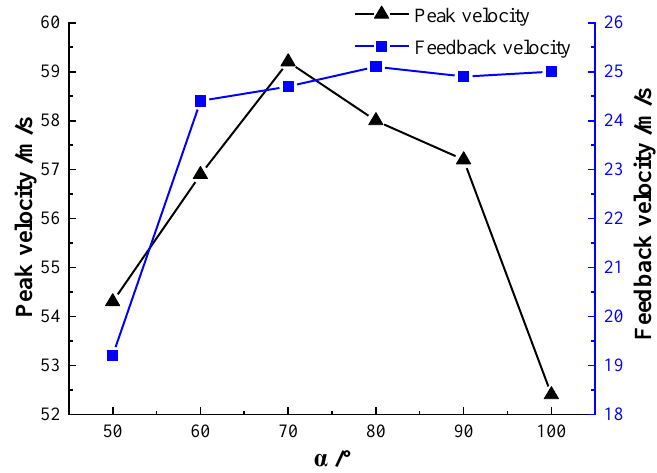
Figure 19. Curves of peak velocity and feedback velocity with wall reflection angle.